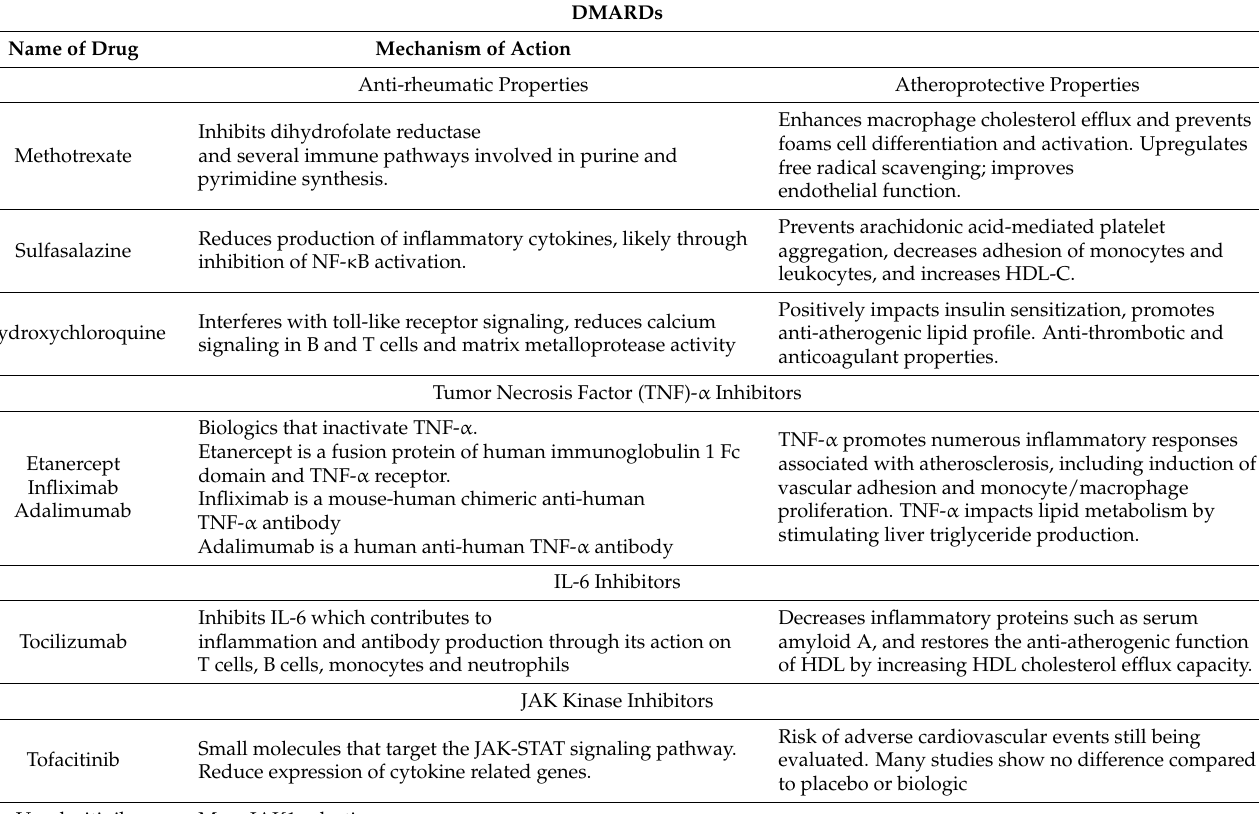
Table 1. Therapies Effective Against RA and